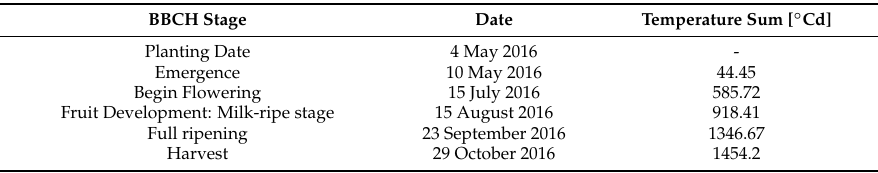
Table 2. Basic data of the